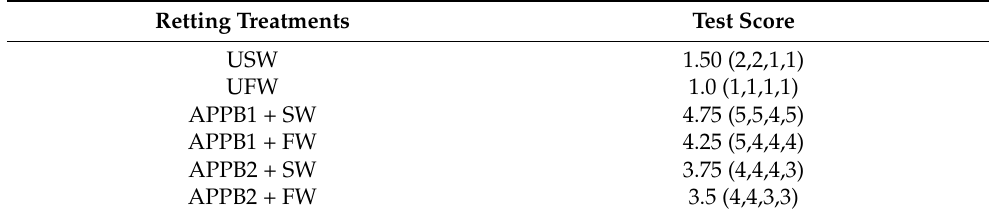
Table 2. Fried test scores of the kenaf retting